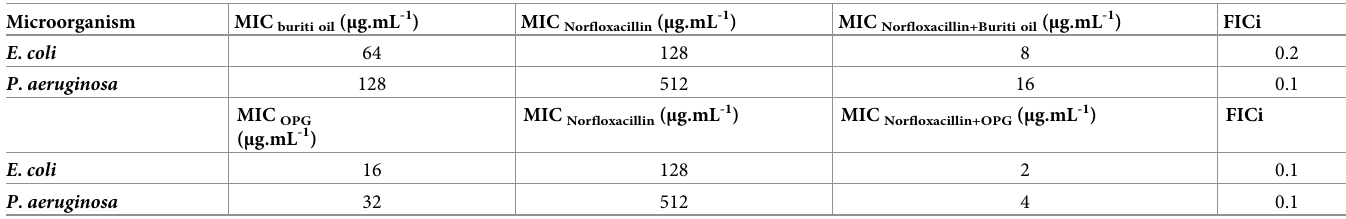
MIC: Minimum inhibitory concentration, FIC: Fractional inhibitory concentration, FICi: Fractional inhibitory concentration index, OPG: Buriti oil nanoencapsulated in porcine